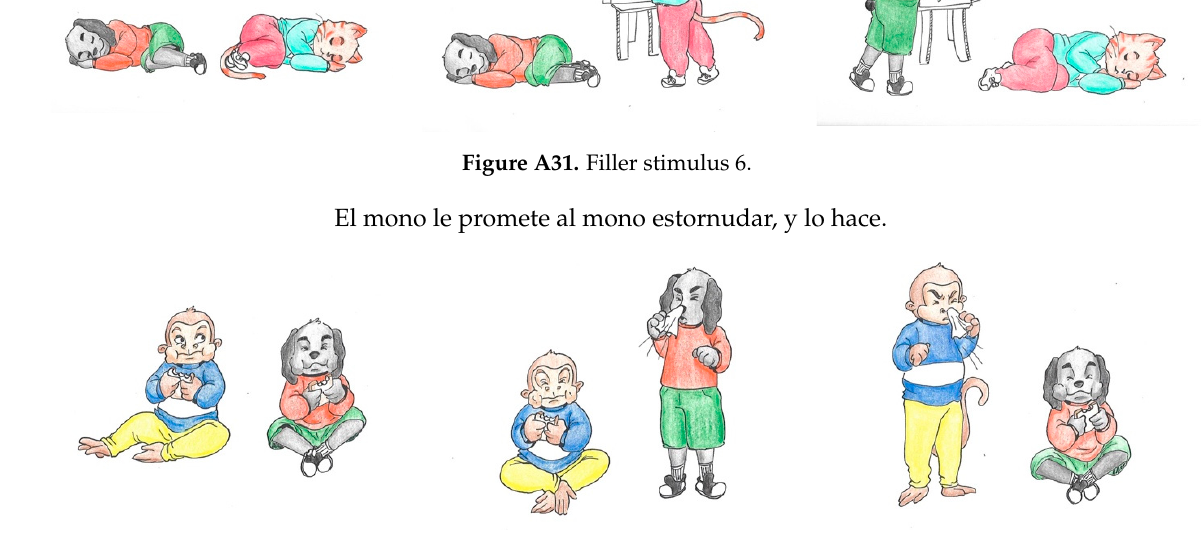
Figure A32. Filler stimulus 7.